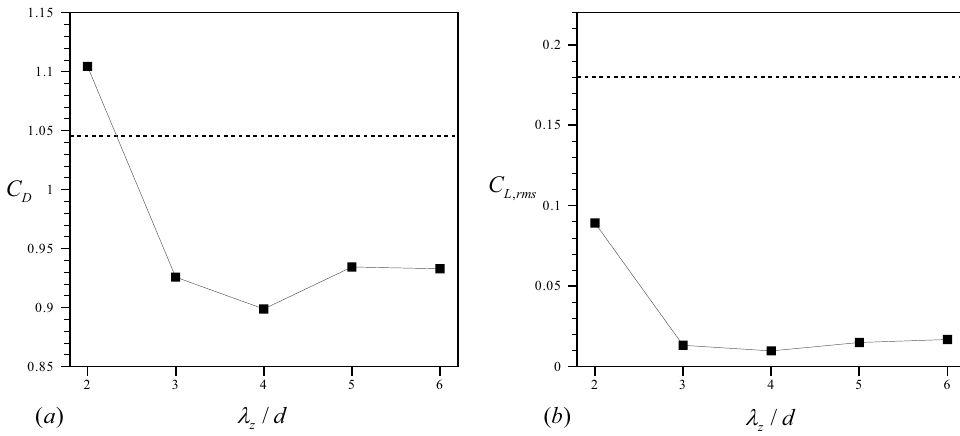
Figure 6. Variations of drag and lift coefficients with the spanwise tab spacing λ z : ( a ) mean drag coefficient; ( b ) rms of lift coefficient. Here, we use the fixed tab size of l y = 0.2 d and l z = 0.3 d , and dashed lines denote values for the uncontrolled